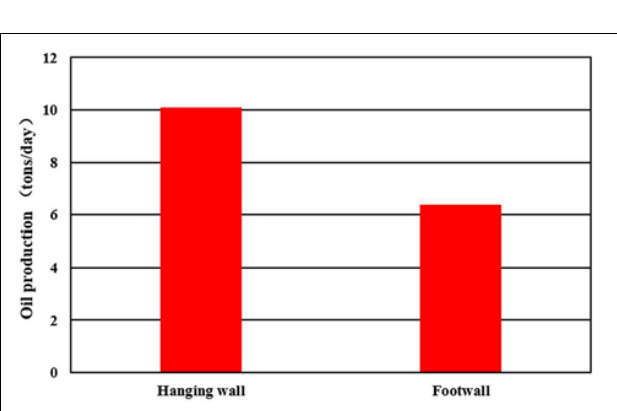
FIGURE 13 | The oil production in the wells located at different parts of fault (data from Lyu et al.,